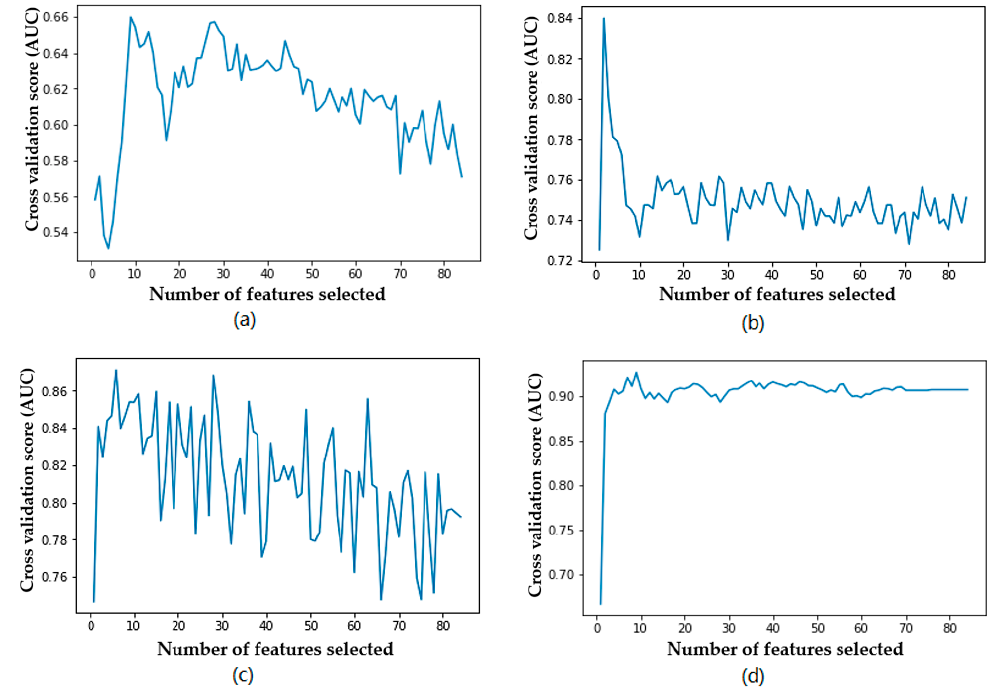
Figure 5. Relationship between AUC and number of features used by the classifier: ( a ) SVM, ( b ) decision tree, ( c ) RF, ( d ) XGBoost.